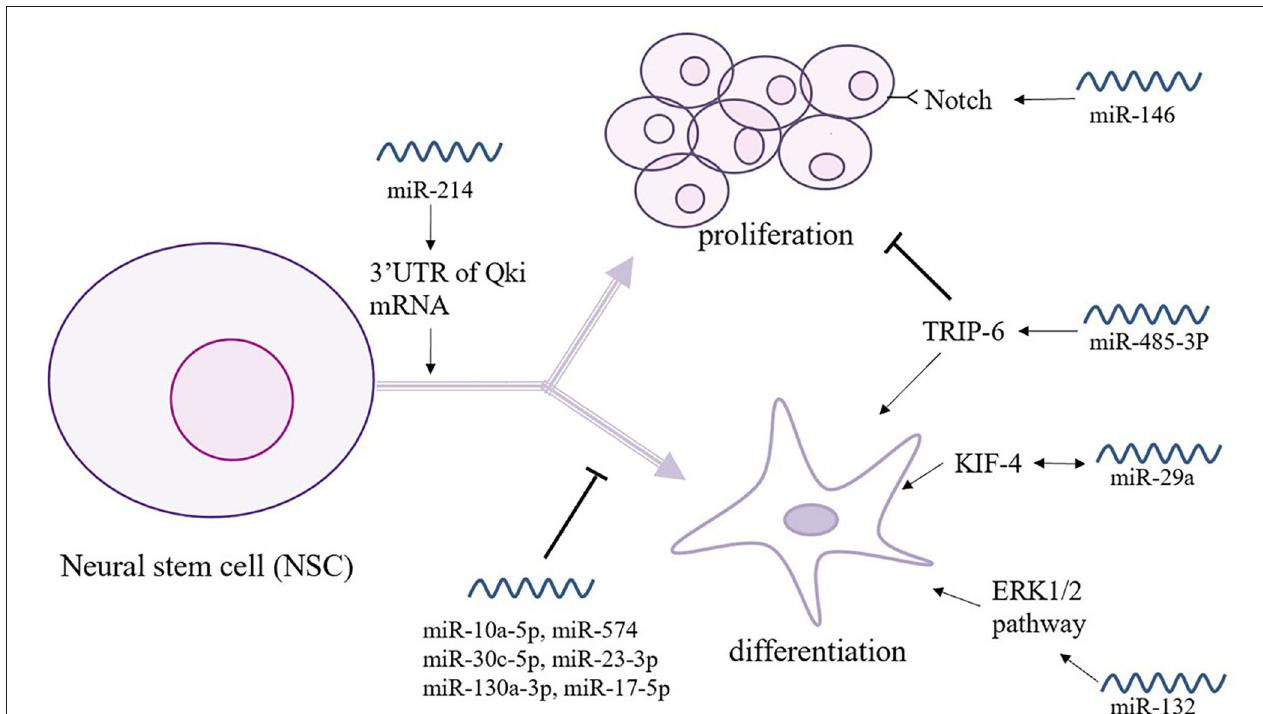
FIGURE 3 | The relationship between miRNAs and neural stem cells (NSCs). NSCs play a key role in brain homeostasis and repair and show intrinsic pleiotropic properties. Thus, the intimate connections between NSCs and miRNAs are under study. As shown here, miR-146 and miR-585-3p play an opposite role in the proliferation and differentiation of NSCs. Moreover, a great number of miRNAs participates in the self-renewal and gene expression of